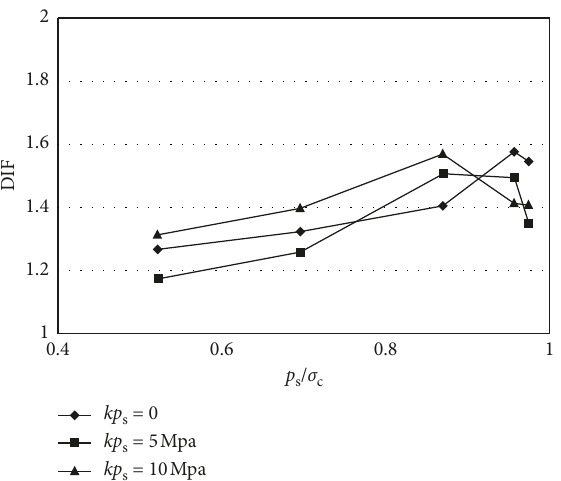
Figure 5: Variation of combined static and dynamic strength with static stress under different confining stress (DIF is dynamic increase factor of rock strength, p is the static stress, and σ is the static uniaxial compressive s c